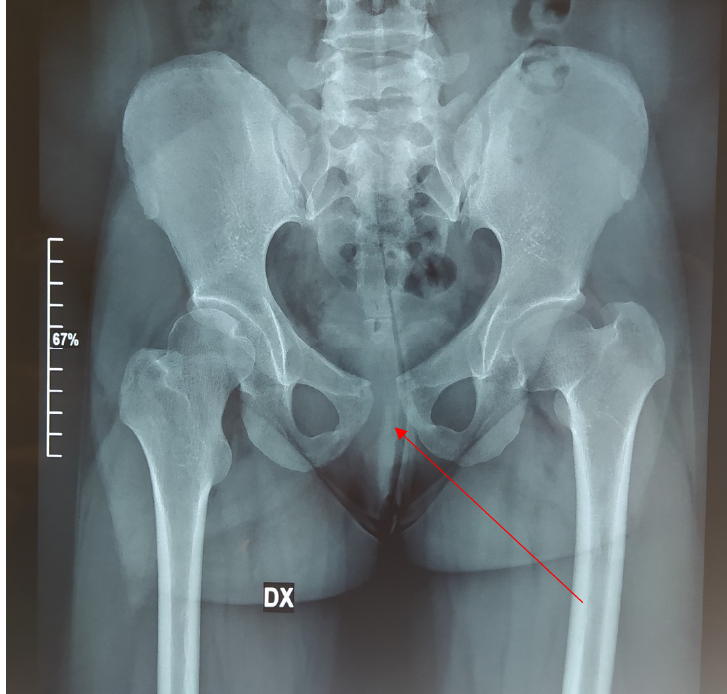
Figure 12. Pelvis radiography in 2021 with a wide pubic symphysis (red arrow).